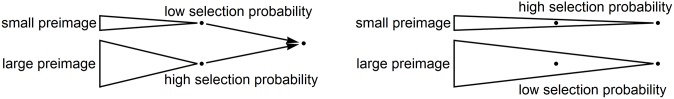
Selection of checkpoints through the selection of starting points.